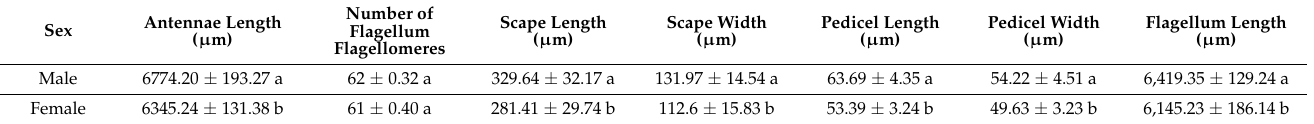
Table 1. General antennal characteristics in Dioryctria rubella